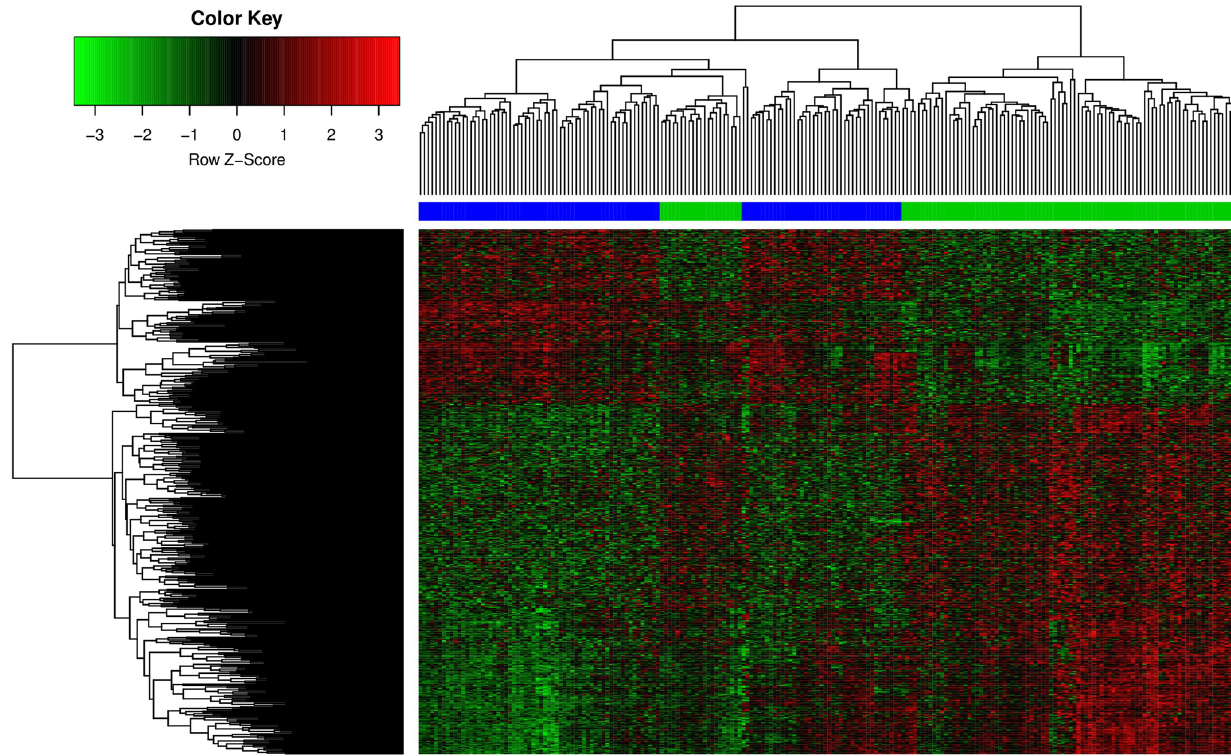
Fig 2. Cluster heatmap. Disease and normal sample are drawn with red and green, respectively.